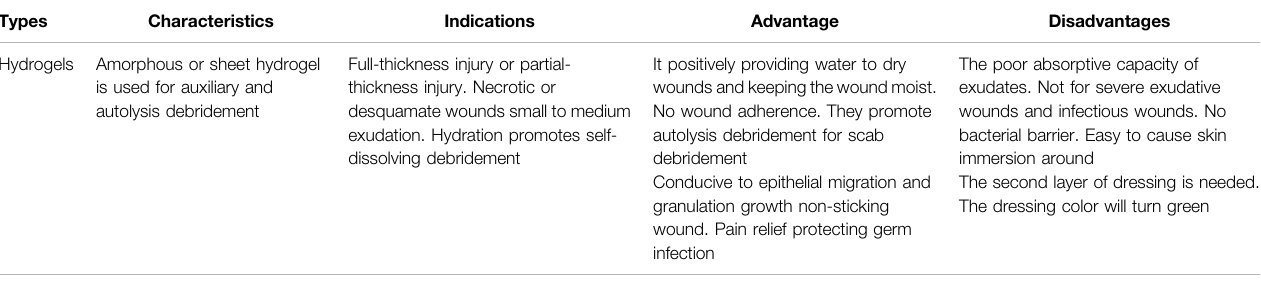
TABLE 3 | Advantages and disadvantages of Hydrogels used as dressing materials. Types